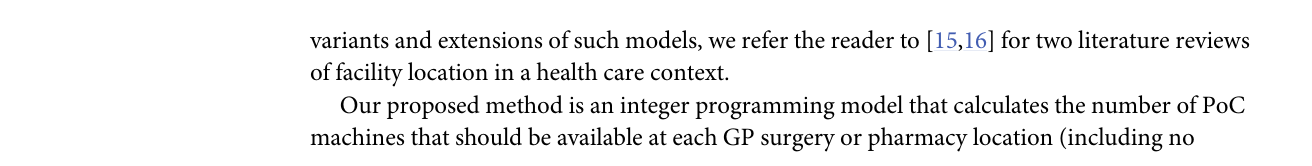
PLOS ONE | https://doi.org/10.1371/journal.pone.0222676 September 17,